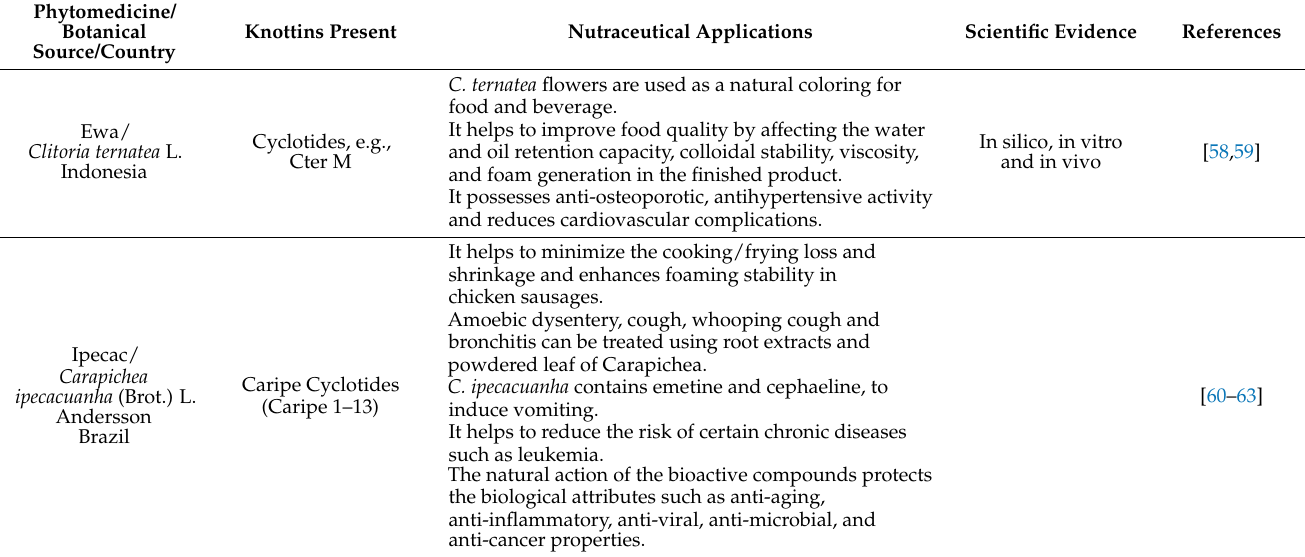
Table 1. Reported knottin-rich phytomedicines used in various parts of the globe as both food and medicine (nutraceuticals) and their botanical